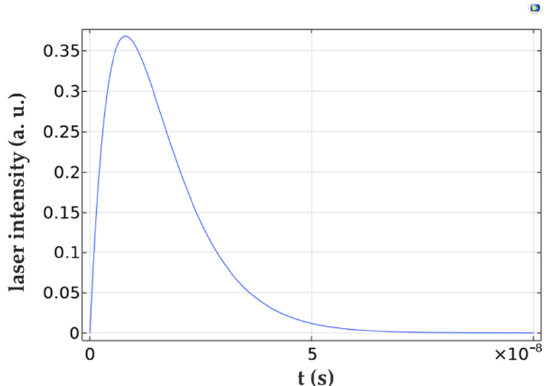
Figure 2. Temporal profile of Gaussian laser pulse with t 0 = 8 ns.